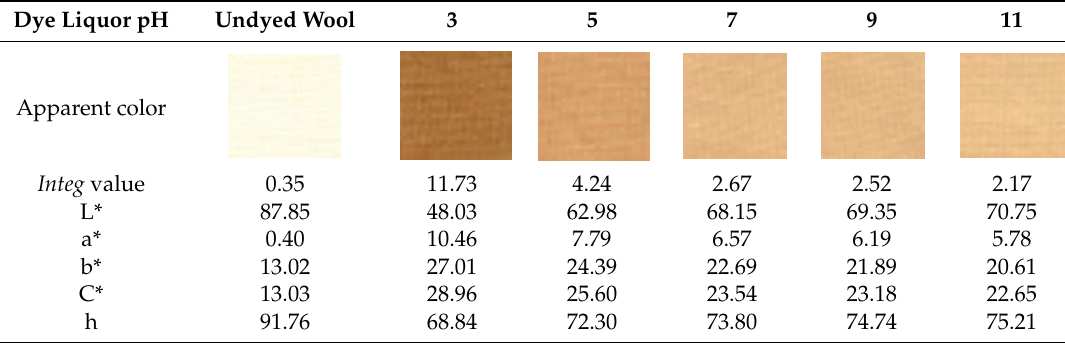
Table 3. The color parameters of dyed wool fabrics with tea polyphenols.